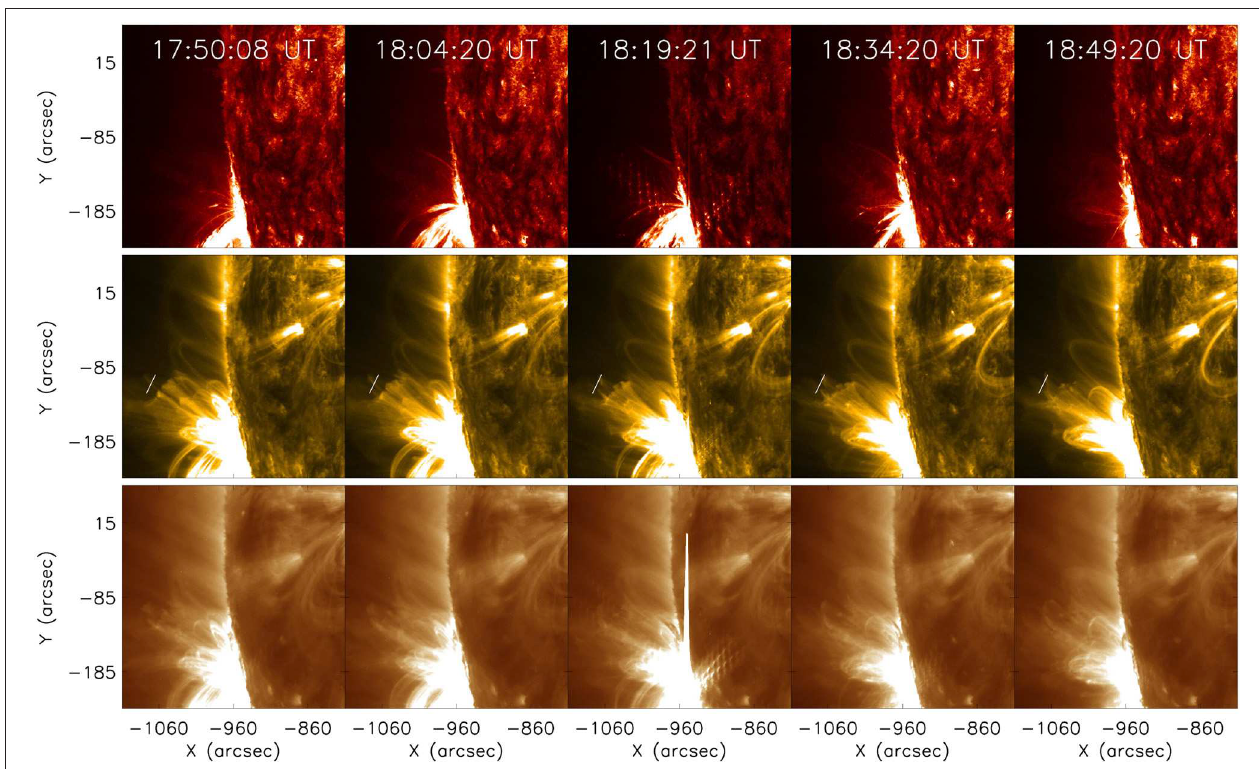
FIGURE 1 | The evolution of the coronal loop system during the hour around the oscillations analyzed here. Plotted are the SDO/AIA 304 Å (top) , 171 Å (middle) , and 193 Å (bottom) channels. The white slit over-laid on the middle row indicates the location of the slit analyzed in this